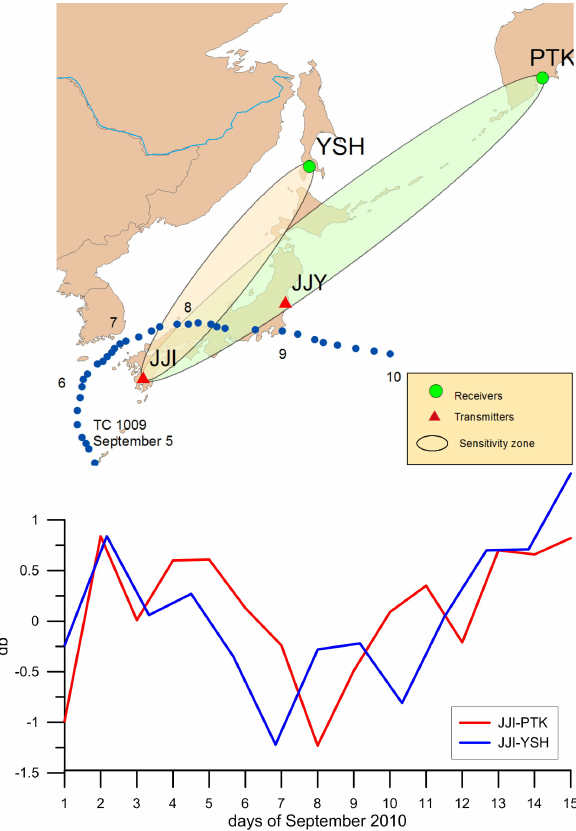
Figure 5. The anomalies in the JJI signal recorded at the PTK and YSH stations during the passage of the TC Malou (1009). Blue solid circles in the top panel show the position of the TC centres on 5–10 September